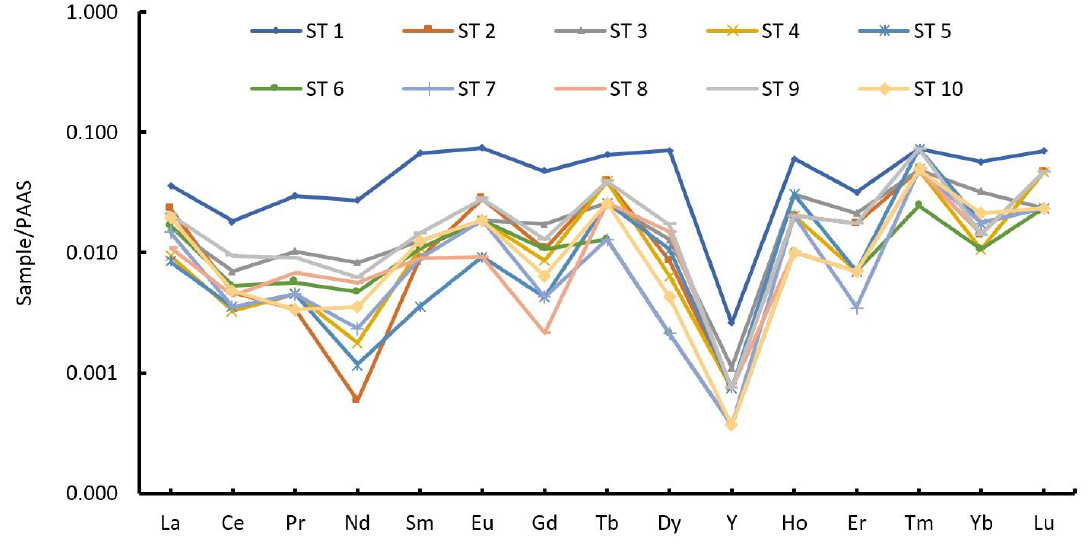
Figure 10. PAAS-normalized [52] REE + Y patterns of the Lake Salda stromatolites. The Eu/Eu* and Ce/Ce* ratios can be used to investigate the oxygen fugacity, pH,